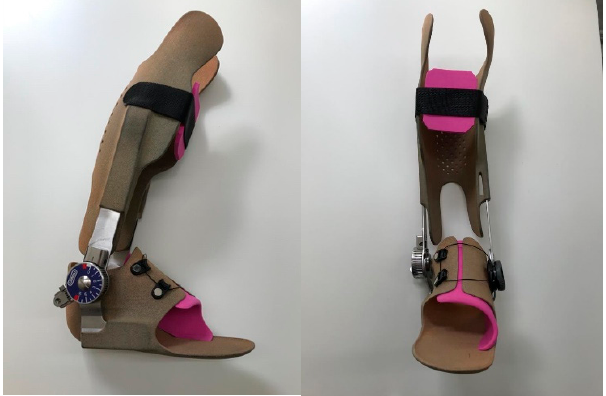
Figure 2. Images of an ankle immobilizing orthosis.